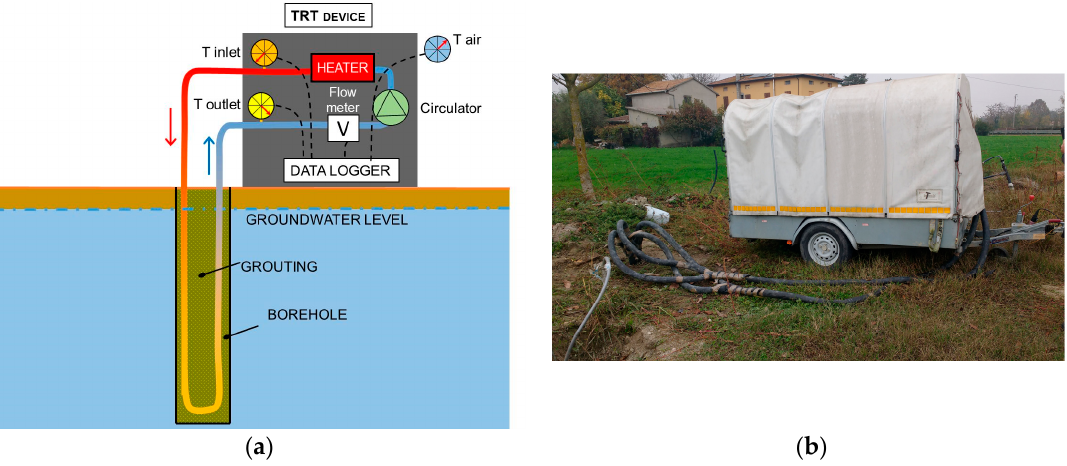
Figure 2. Thermal response test equipment: ( a ) scheme; ( b ) measurements in the test site.